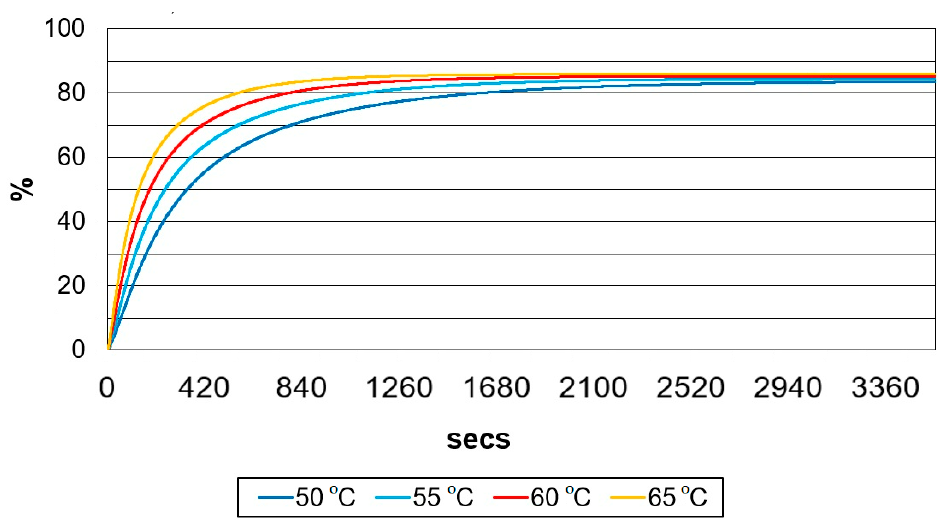
14 of 18 Figure 6. Transesteri fi cation reaction at 60 °C and 9:1 molar ratio. Figures 5 and 6 represent the transesteri fi cation evolution at temperature of 60 °C, with molar ratios of 6:1 and 9:1, respectively. It can be observed that the number of mols of methyl esters increases from 2.10 mols to 2.13 mols along with the increase in the molar